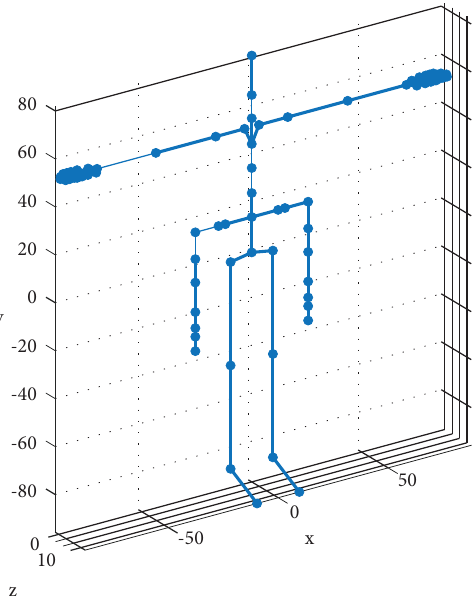
Figure 11: Initial state of the human-SRL skeleton.